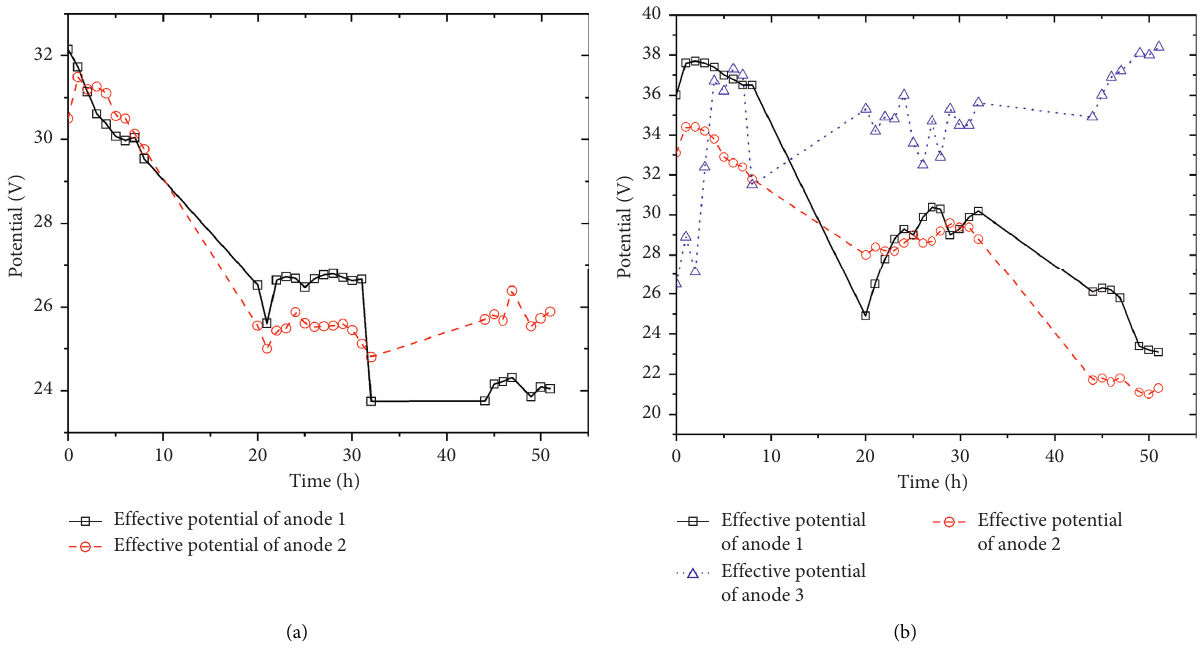
Figure 6: Effective potential change curve. (a) The effective potential of the symmetric unit. (b) The effective potential of the asymmetric